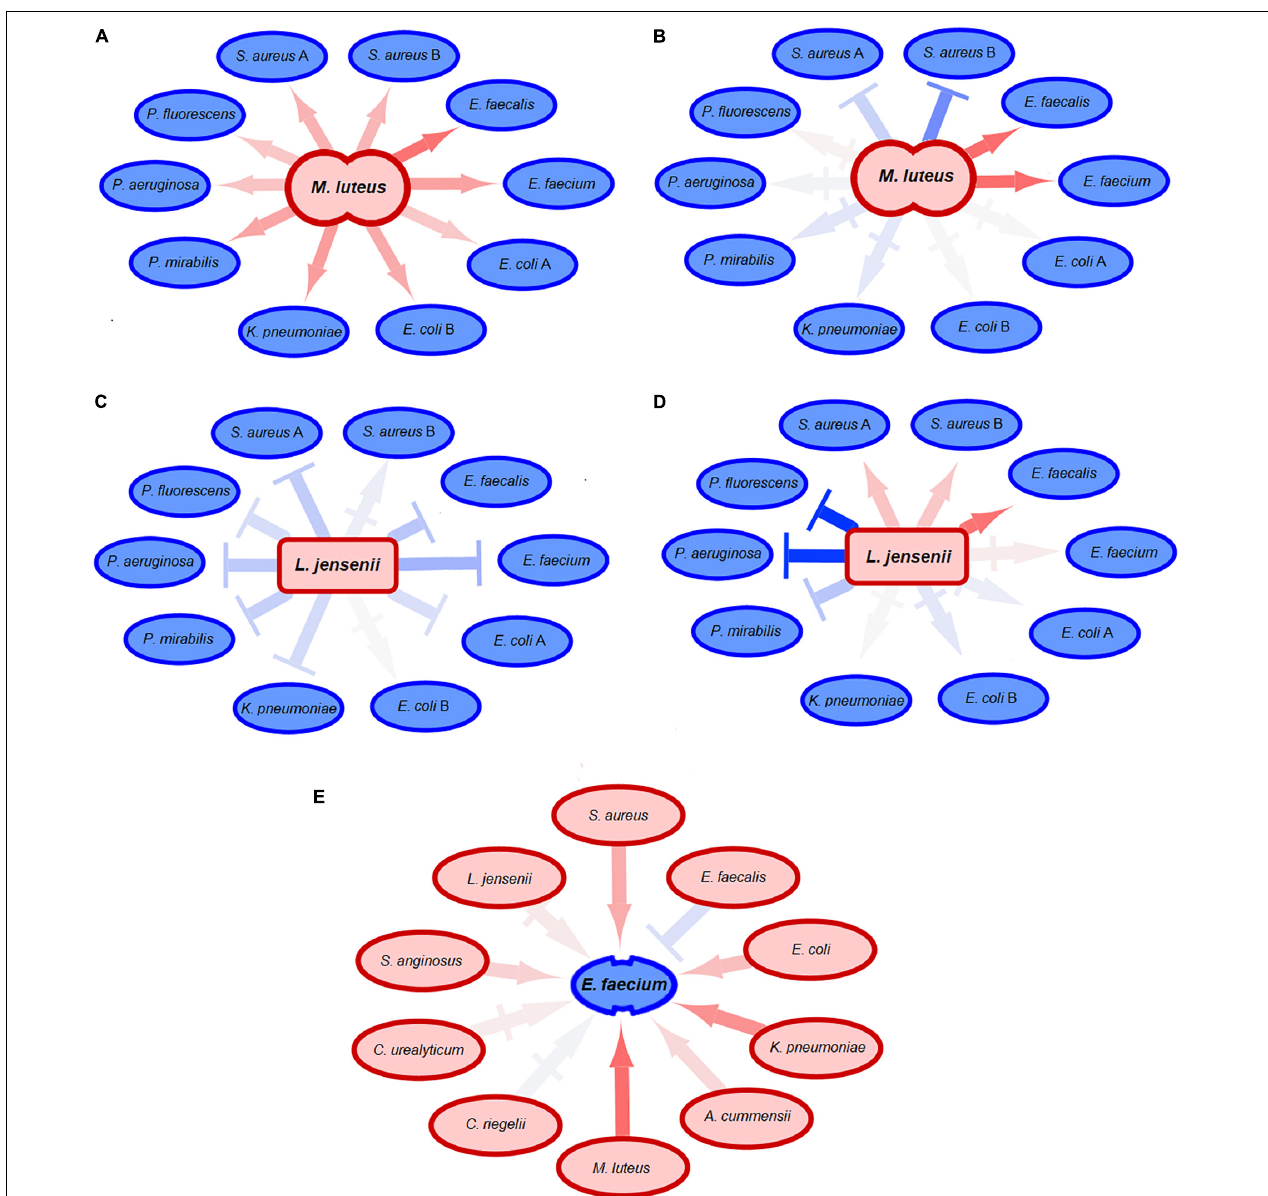
FIGURE 7 | Effect of commensal acceptors on pathogens. Neutral-to-weak interactions are symbolized by | → connectors. The darker the color of a connector, the stronger the growth effect of the donor was. Red connectors indicate positive interactions, blue connectors negative interactions. (A) The conditioned medium of the commensal donor M. luteus shortens the lag phase of many uropathogens. The effect of commensal donors on uropathogens seems to be donor-driven. (B) The conditioned medium of the same commensal M. luteus donor as in (A) does not have comparable effects on the population size of the tested uropathogenic acceptors, indicating that the effect on population size of acceptors is not donor-driven. (C) The commensal donor L. jensenii increases the length of the lag phase of uropathogenic acceptors. Just like in (A) , effects on the lag phase of uropathogens by commensals suggests that the effect on lag-phase is